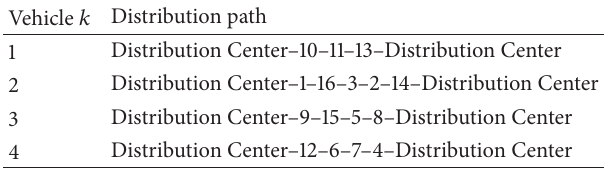
Table 7: The distribution path figure of basic ant colony algorithm. Vehicle 𝑘 Distribution path